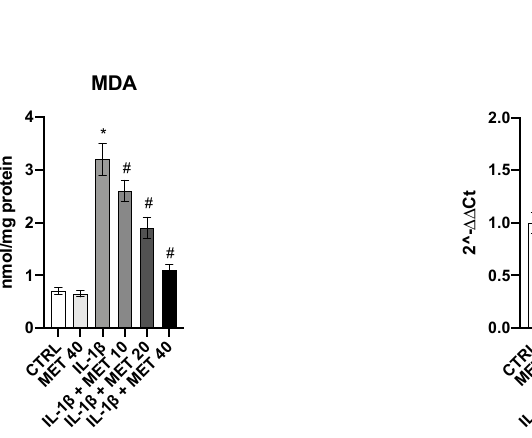
Figure 2. Effects of metaxalone on MDA generation ( A ), Nrf2 mRNA expression ( B ), and Nrf2 protein levels ( C ). Values are expressed as the means ± SD. *, p < 0.0001 vs. CTRL; #, p < 0.0001 vs. IL-1 β .